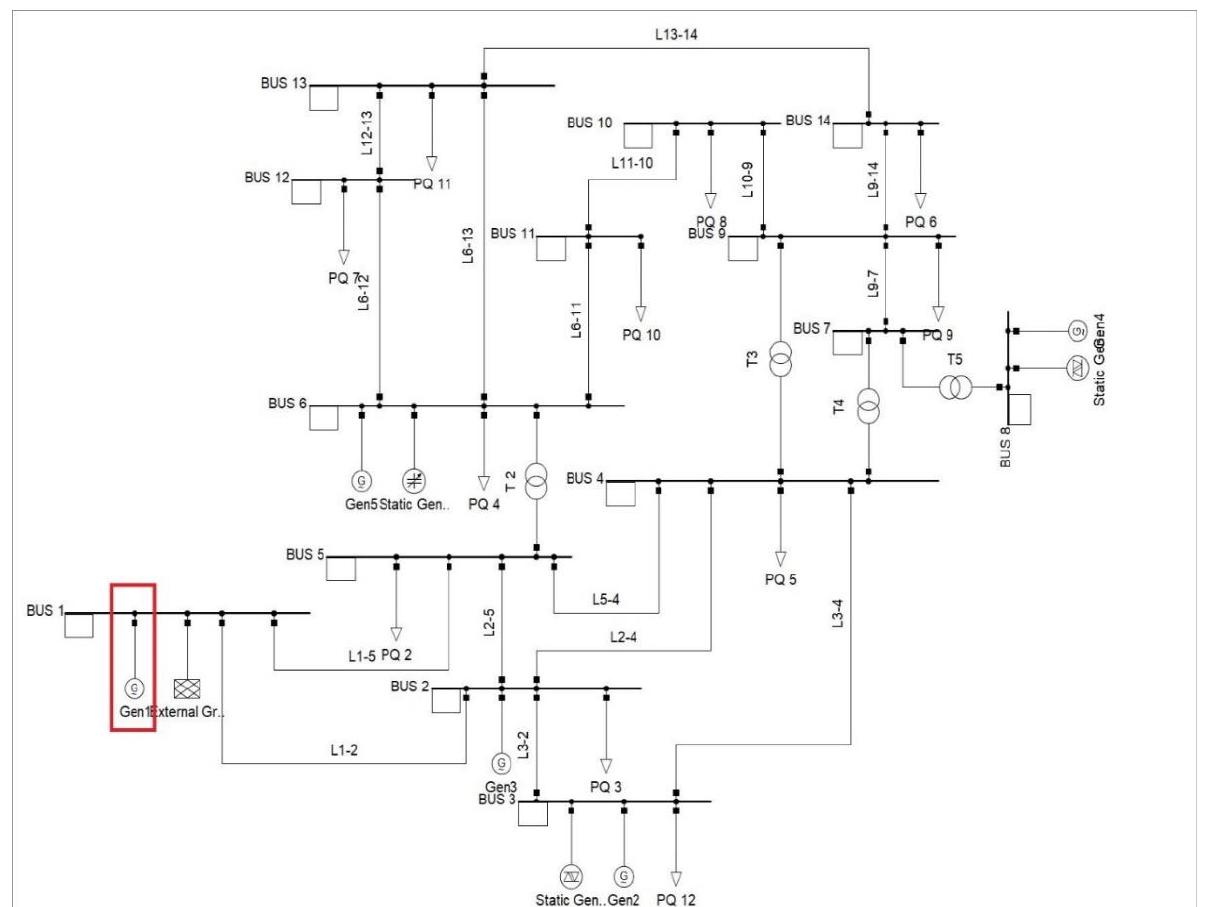
Figure 4. IEEE 14 bus system model in DIgSILENT PowerFactory simulation interface. Table 1. Local oscillatory modes for the analyzed system without the PSS